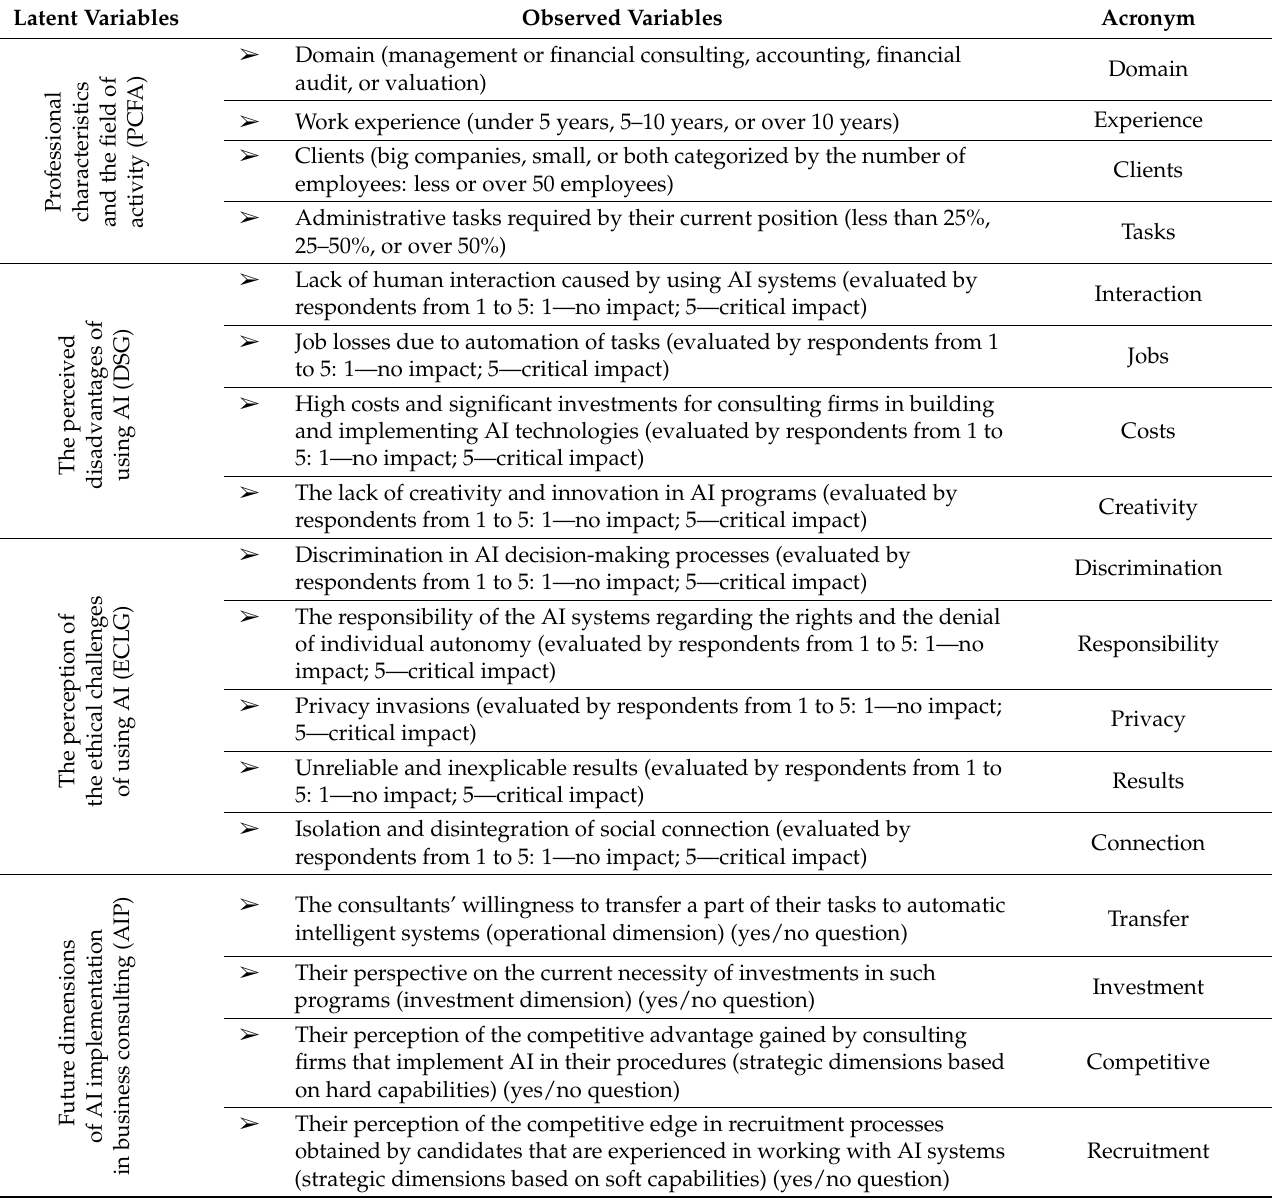
Table 2. Variables used in